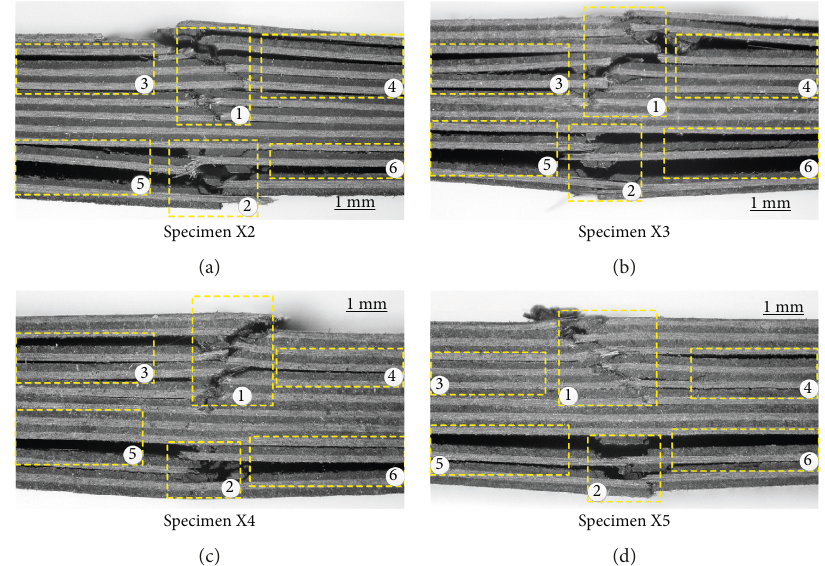
Figure 9: Failure modes at characteristic point E. (a) Specimen X1, (b) Specimen X2, (c) Specimen X3, (d) Specimen X4, and (e) Specimen